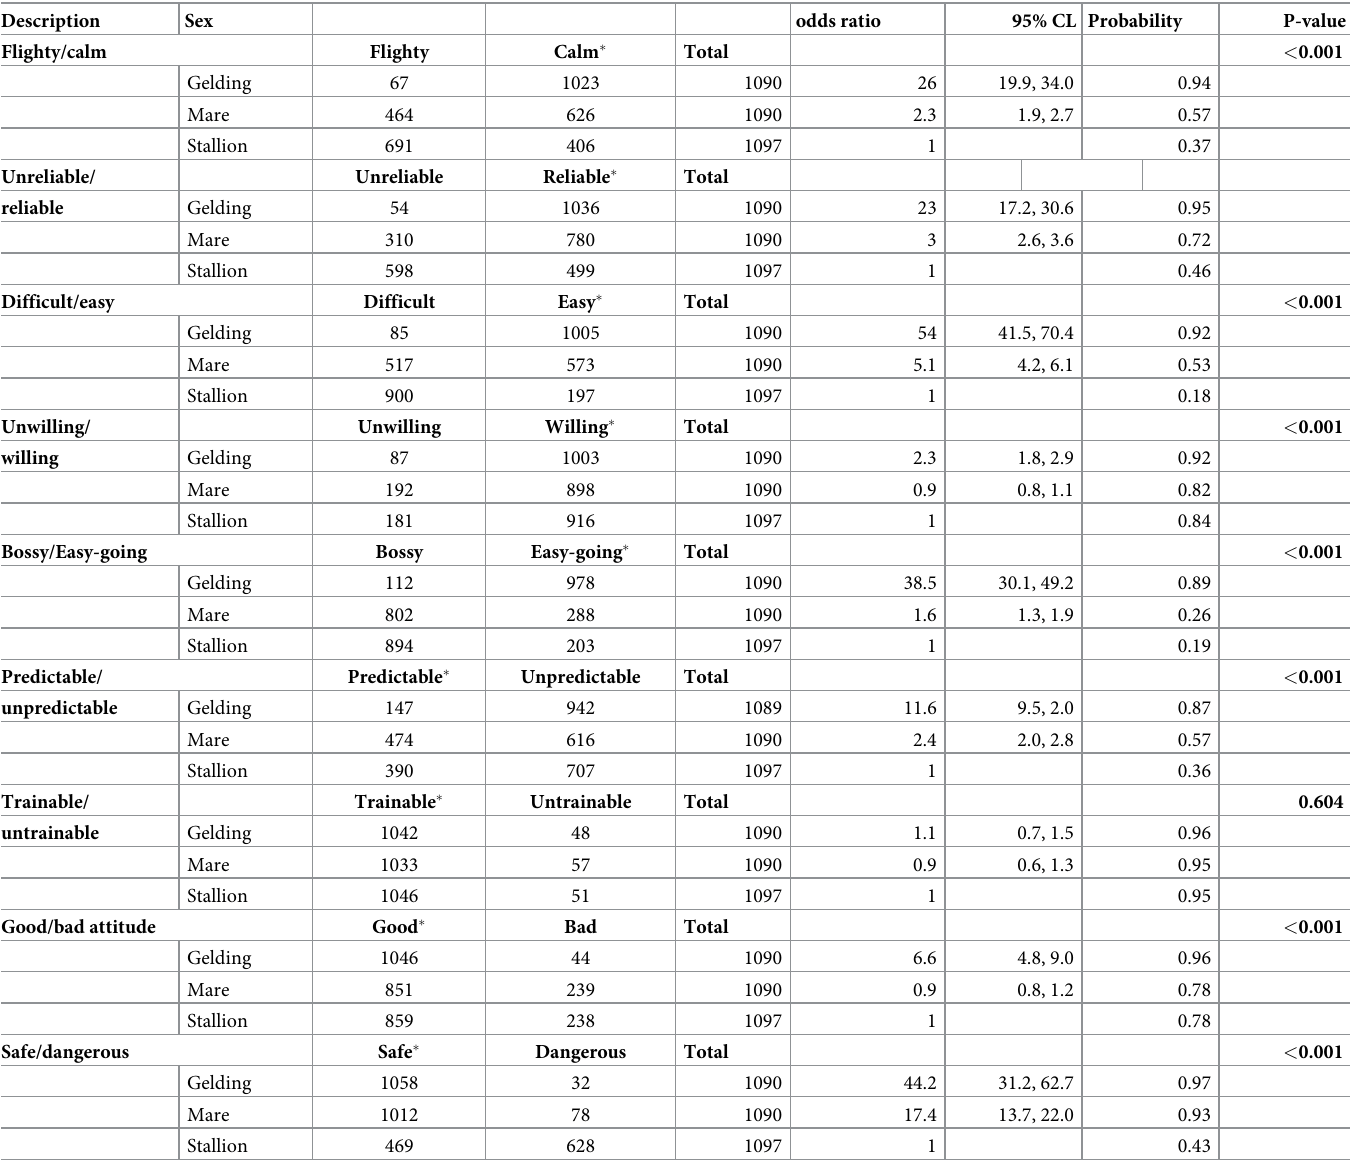
Table 3. Odds ratio estimates for horse descriptor